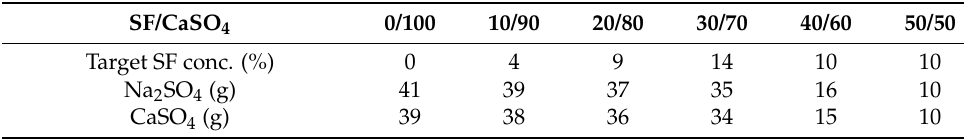
Table 1. Different components for SF/CS